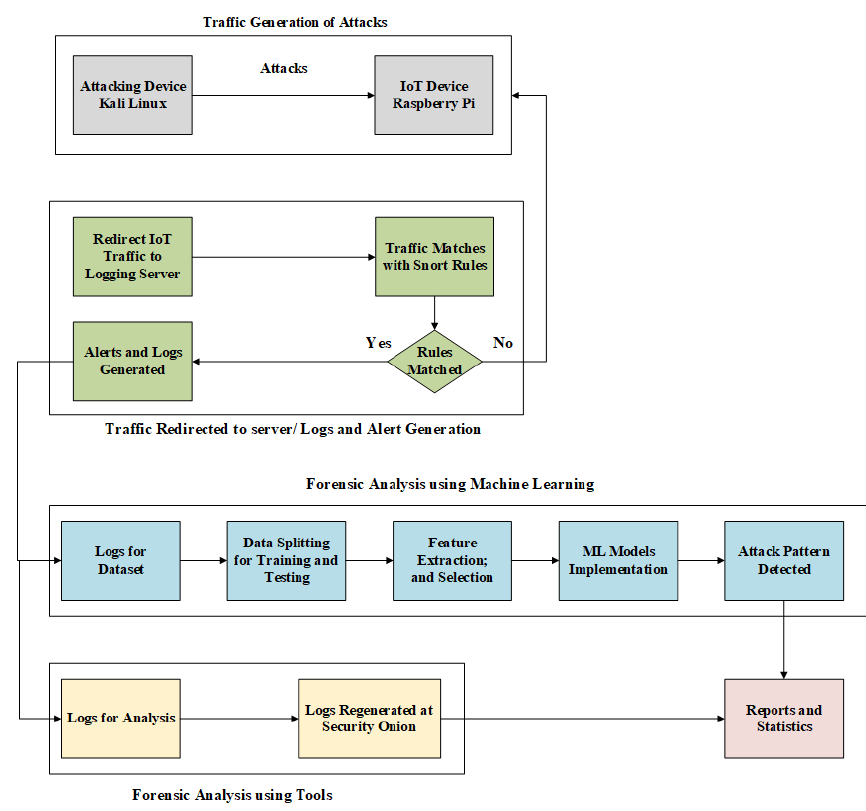
Figure 2. Proposed methodology for forensic analysis of IoT